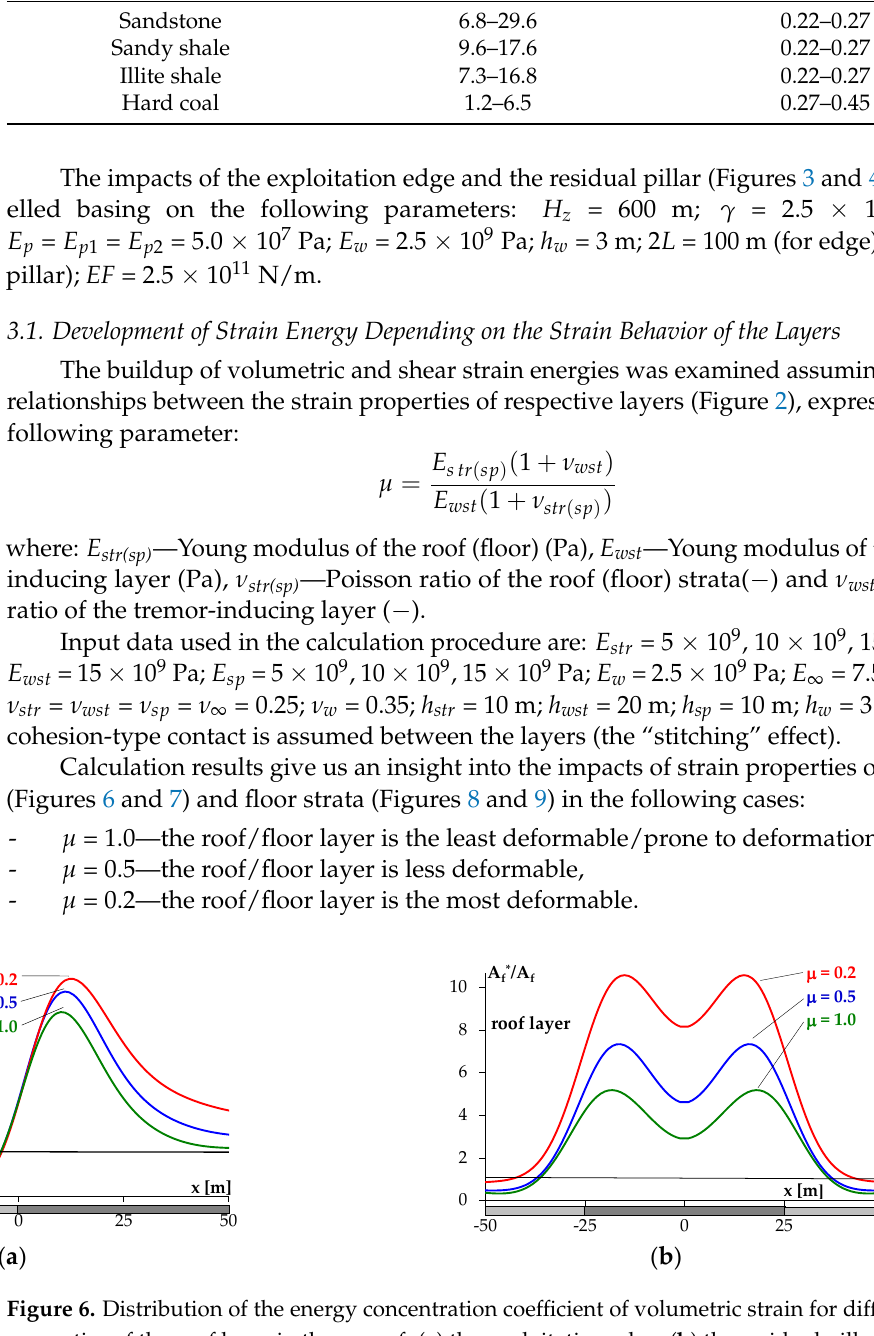
Figure 7. Distribution of the energy concentration coefficient of volumetric strain for different strain properties of the roof layer in the area of: ( a ) the exploitation edge, ( b ) the residual pillar.